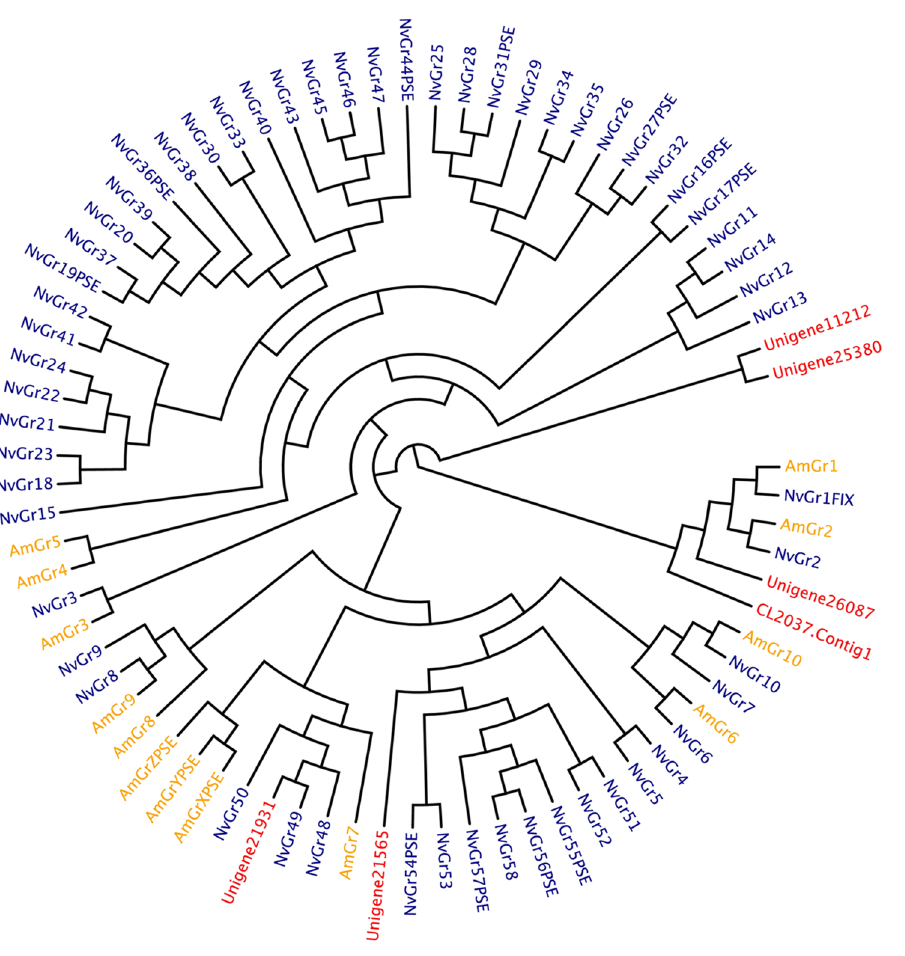
Figure 3. Phylogenetic tree of the gustatory receptor (Gr) family in S.endius , N.vitripennis and A.mellifera . AmGrs are marked in orange, NvGrs are in blue and PvGrs are red.